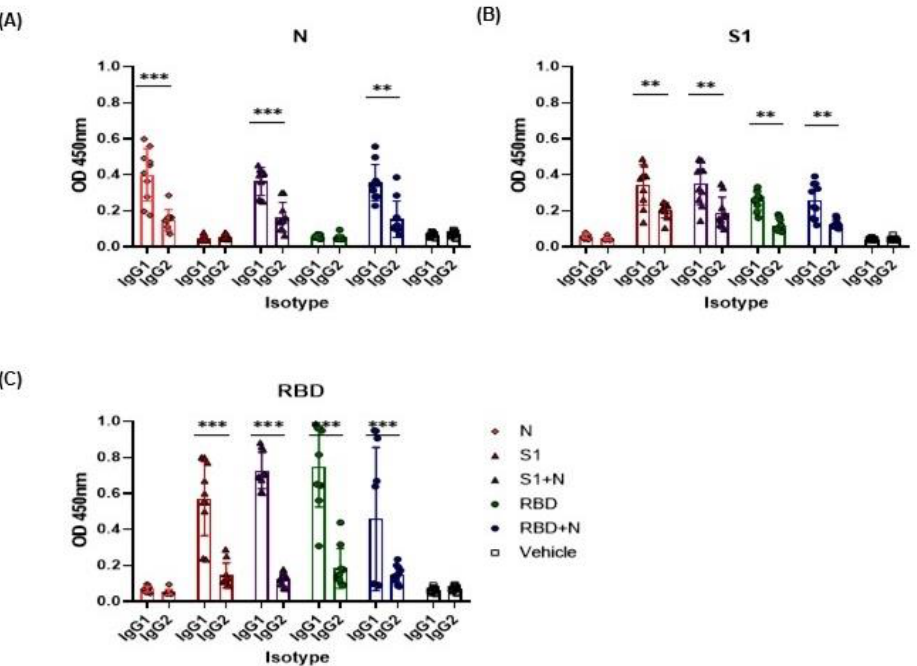
Figure 4. Recombinant proteins N ( A ), S1 ( B ), and RBD ( C ) of SARS-CoV-2 induce IgG1 and IgG2 antibody responses. The IgG subclass antibodies against the N, S1, and RBD proteins of SARS-CoV-2 were evaluated using ELISA 80 days after immunization. Sera were diluted to 1:100 and O.D. at 450 nm was measured. Student’s t -test was used for statistical analysis; bars represent the mean ± SD. * p < 0.05, ** p < 0.01, *** p < 0.001. p ≤ 0.05 was considered statistically significant. Prism v.8 software was used for statistical analyses (GraphPad Inc., La Jolla, CA, USA).